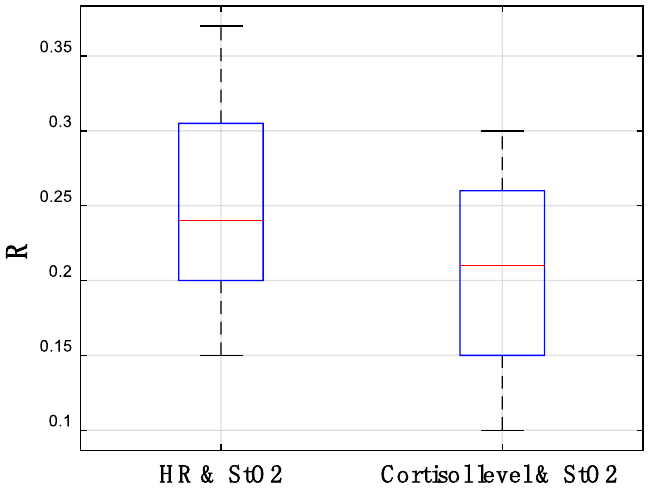
Figure 7. Correlation R value between StO 2 and ground truth (cortisol level and HR) under stress conditions.